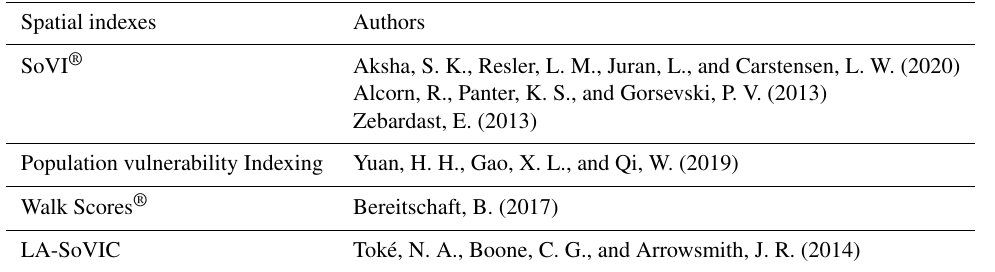
Table 7. Spatial indexes for socio-economic vulnerability assessments.